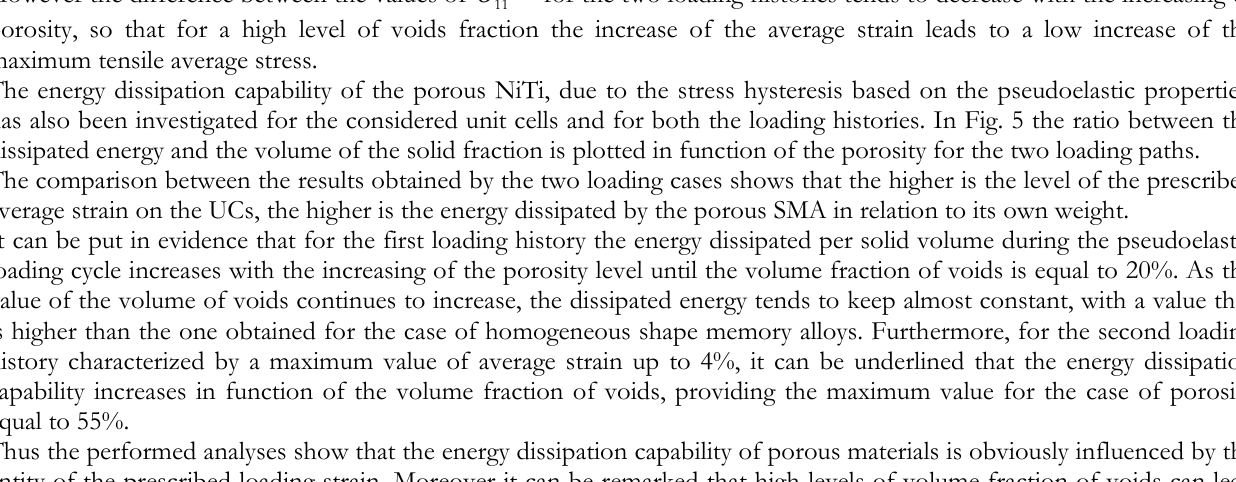
x -direction for the second loading 1